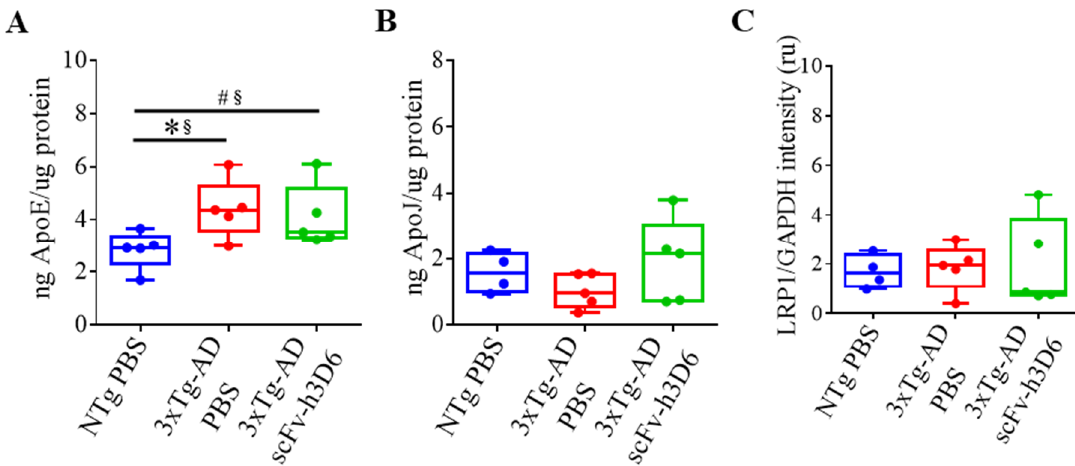
Figure 7. Apolipoprotein levels in the hippocampus are not modified after scFv-h3D6 treatment. ( A , B ) ApoE and apoJ levels as measured by ELISA (in nanograms) and normalized by the total amount of protein as quantified by the BCA assay (in micrograms) in the TBS-soluble fraction. ( A ) ApoE levels. ( B ) ApoJ levels. ( C ) LRP1 levels were measured by Western blotting and normalized by GAPDH levels. Intensity is expressed in relative units. Three replicates for each experiment. Data are expressed as medians in box plots, and whiskers represent the minimum and maximum values. Statistical differences were assessed with the non-parametrical test U Mann-Whitney. * Significant differences p ≤ 0.05; # Marginal significance p ≤ 0.1; § r ≥ 0.68.